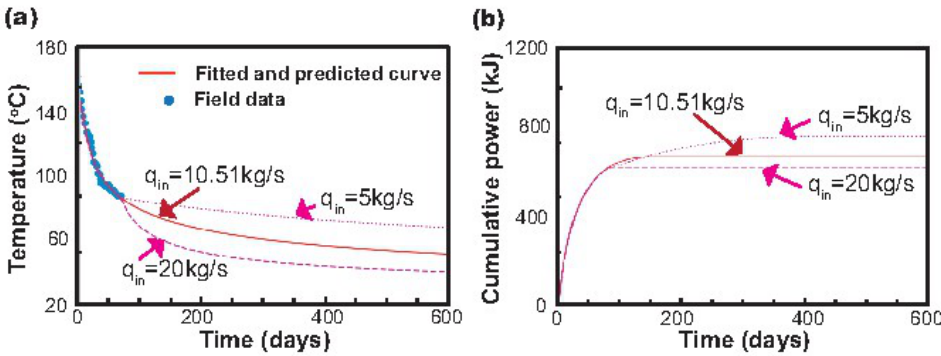
Figure 17. Future prediction by using Fenton Hill data. ( a ) Temperature declines for different injection rates and ( b ) cumulative power for different injection rates.